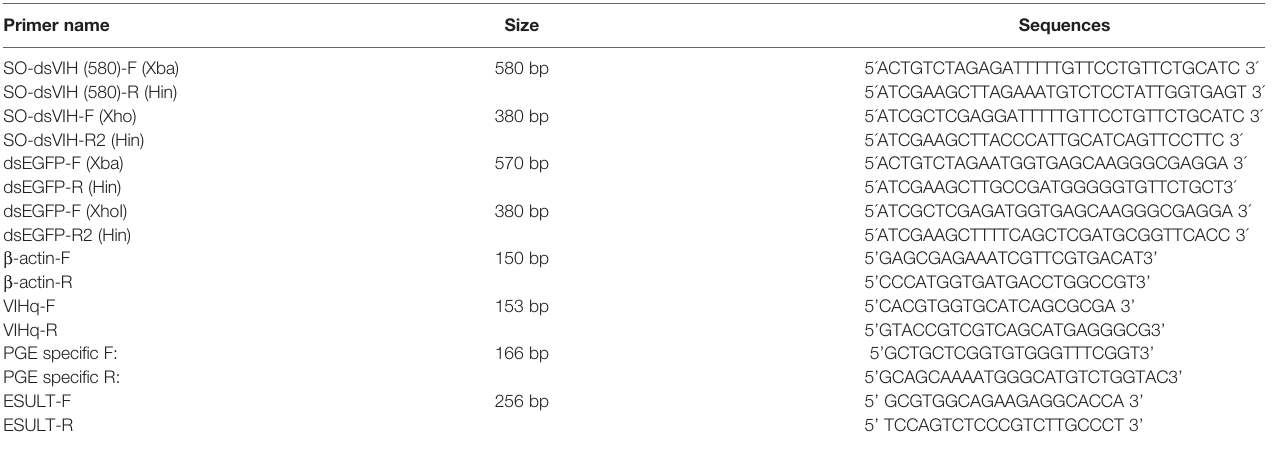
TABLE 1 | Primers used for recombinant plasmids construction, RT-PCR and Real-time